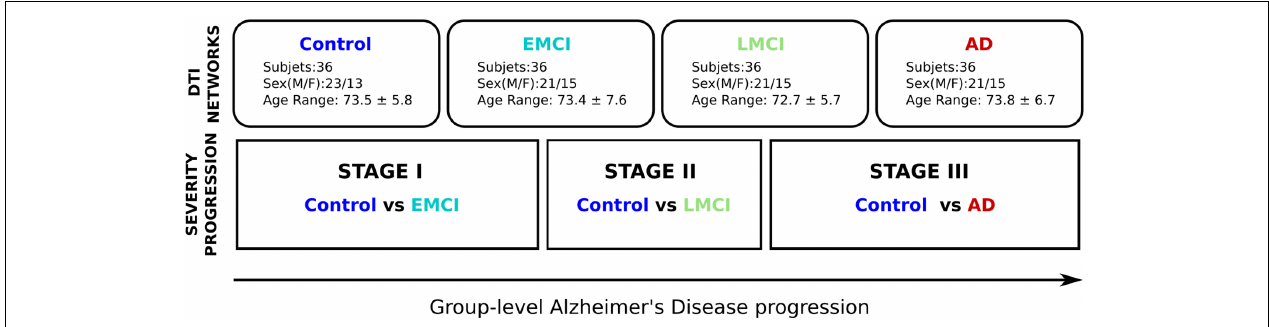
FIGURE 1 | Methodological sketch. Alzheimer’s disease progression is addressed across three stages. Four groups of 36 subjects each at different stages of AD (Control, Early and Late MCI, Alzheimer) following the ADNI classification criterion. All groups have been balanced with respect to age, sex and years of education. Brain connectivity patterns and its relation with disease progression are accomplished by comparing the control group with the rest of groups, i.e., Control vs. EMCI (stage I), Control vs. LMCI (stage II), and Control vs. AD (stage